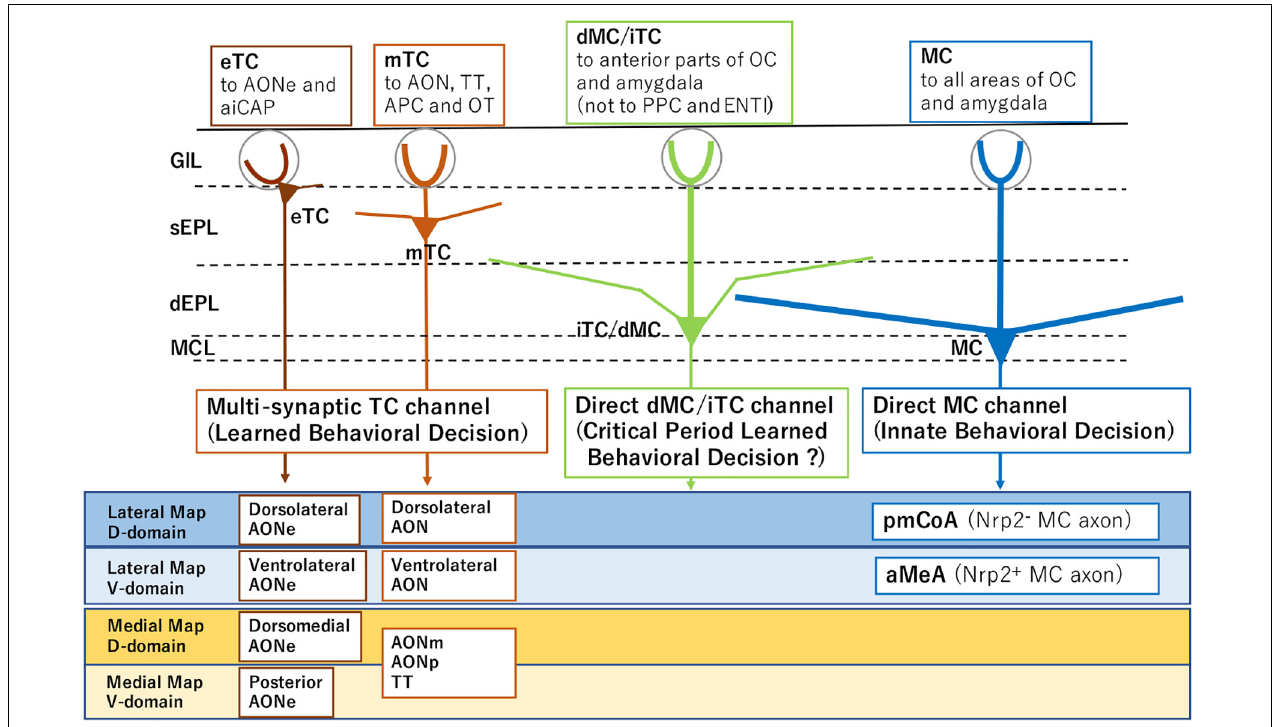
FIGURE 1 | Subsets of projection neurons for distinct behavioral decisions. External tufted cells (eTC) and middle tufted cells (mTC) serve as multi-synaptic channels to the amygdala for learned behavioral decisions. Mitral cells (MC) are direct channels to induce innate behavioral decisions. Internal tufted cells (iTC) and displaced mitral cells (dMC) may serve as direct channels for imprinted behavioral decisions. The diagram also illustrates distinct projection targets of MCs and TCs in each domain of the olfactory bulb (OB). Examples of domain-specific targets are shown for MCs and TCs in the lower boxes. Abbreviations: aiCAP, the most anterolateral isolation of the cap compartment of the olfactory tubercle (OT); aMeA, anterior region of the medial amygdala; AON, anterior olfactory nucleus; AONe, AON external part; AONm, AON medial part; AONp, AON posterior part; APC, anterior piriform cortex; ENTl, lateral entorhinal area; pmCoA, posteromedial cortical amygdala; PPC, posterior piriform cortex; TT, tenia tecta; Nrp2, Neuropilin 2; D, dorsal; and V,